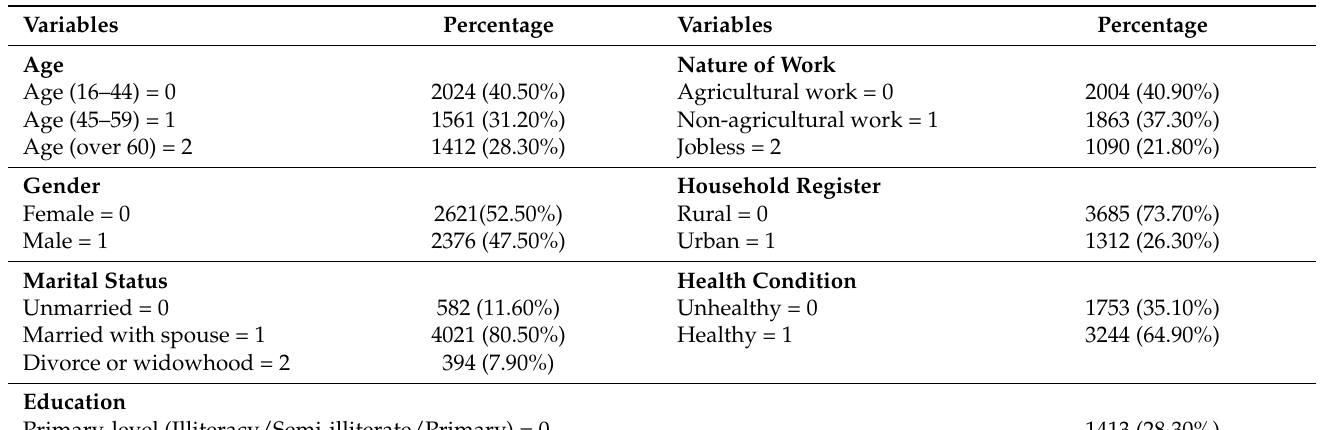
Table 1. The results of the descriptive analysis ( n = 4997).